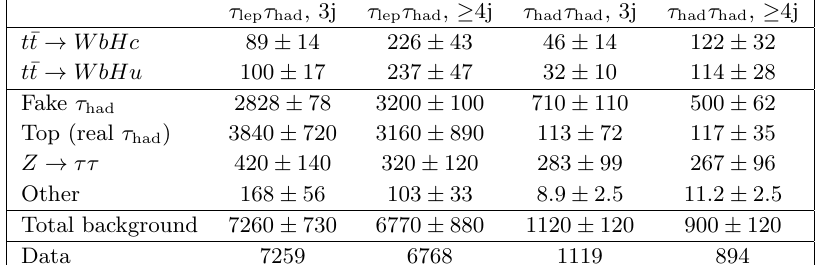
Table 7 . tqH ( (cid:28)(cid:28) ) search: predicted and observed yields in each of the analysis regions considered. The prediction is shown before the (cid:12)t to data. Also shown are the signal expectations for t (cid:22) t ! WbHc and t (cid:22) t ! WbHu assuming B ( t ! Hc ) = 1% and B ( t ! Hu ) = 1% respectively. The contributions with real (cid:28) had candidates from t (cid:22) t , t (cid:22) tV , t (cid:22) tH , and single-top-quark backgrounds are combined into a single background source referred to as \Top (real (cid:28) had )", whereas the small contributions from Z ! ‘ + ‘ (cid:0) ( ‘ = e; (cid:22) ) and diboson backgrounds are combined into \Other". The quoted uncertainties are the sum in quadrature of statistical and systematic uncertainties of the yields, excluding the normalisation uncertainty of the fake (cid:28) had background, which is determined via a likelihood (cid:12)t to data.